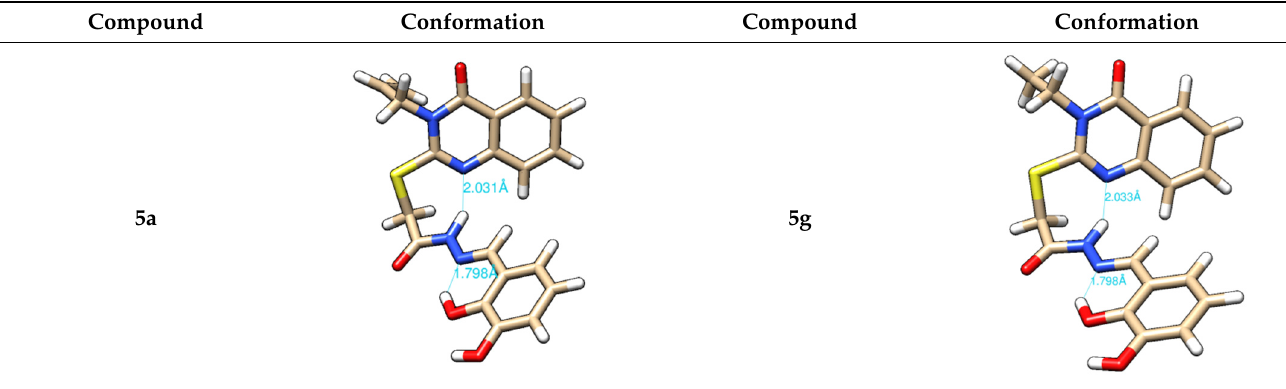
Table 8. The conformation of the lowest energy of the compounds with the depiction of the resulting hydrogen bonds.